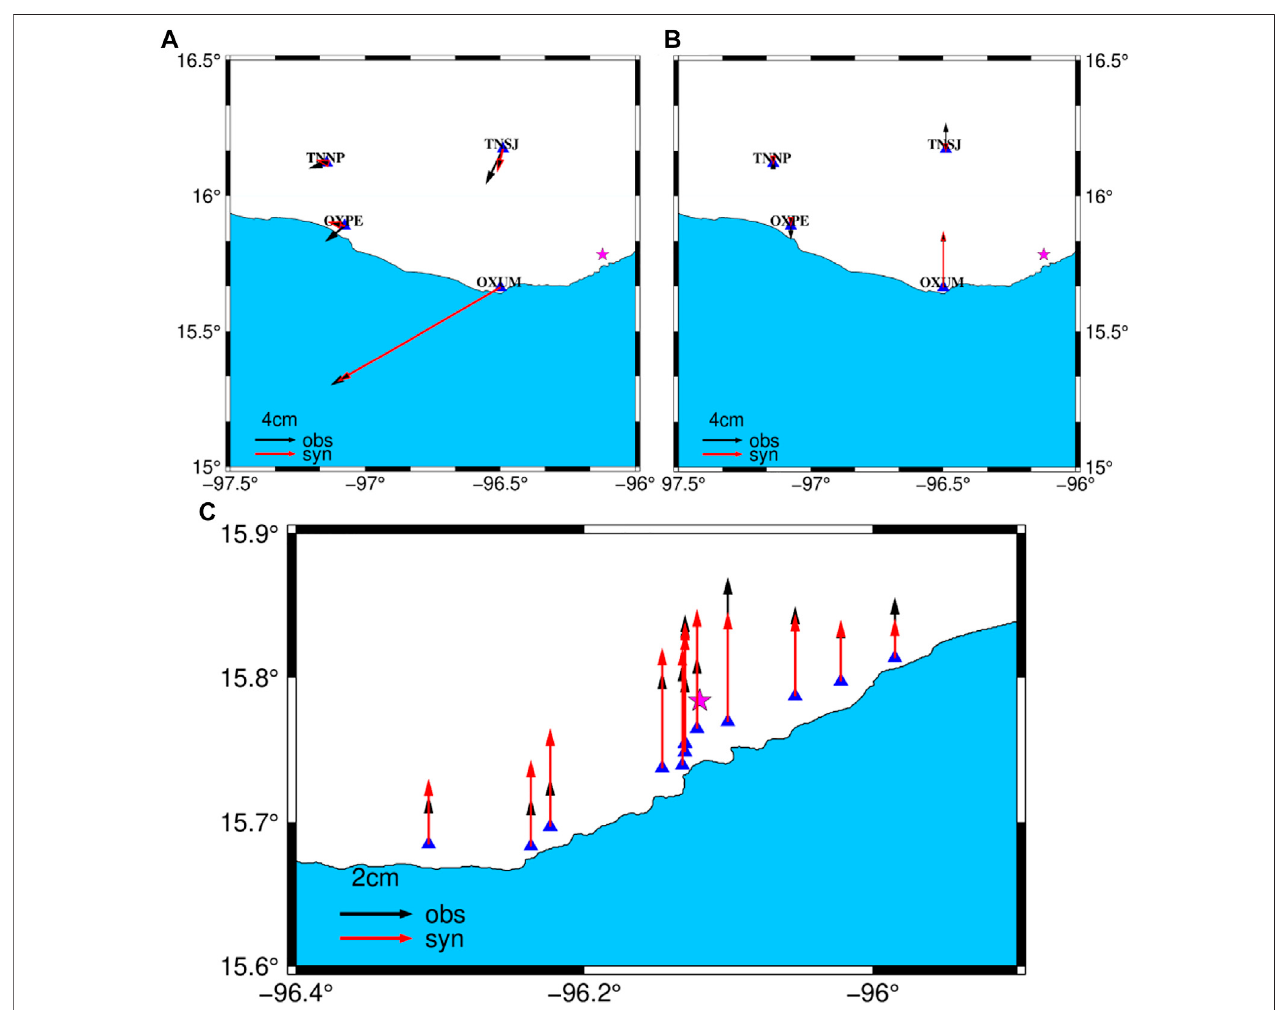
FIGURE9|(A) Comparisonbetweentheobservedhorizontal(black)andsynthetichorizontal(red)staticGPSdata. (B) Comparisonbetweentheobservedvertical (black) components and synthetic vertical (red) static GPS data. (C) Comparison between the observed (black) and synthetic (red) coastal uplift data from the study by Ramírez-Herrera et al.